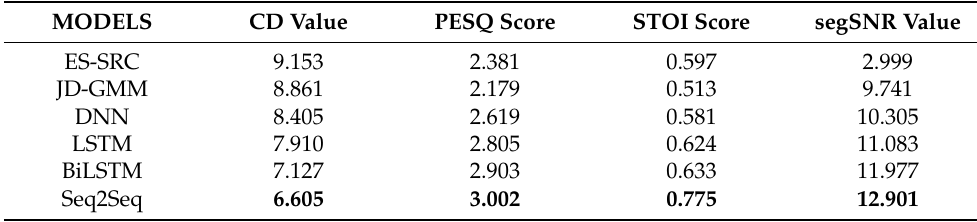
Table 2. Results of the objective assessment of the reference and proposed methods on the MH speaker esophageal corpus test set.